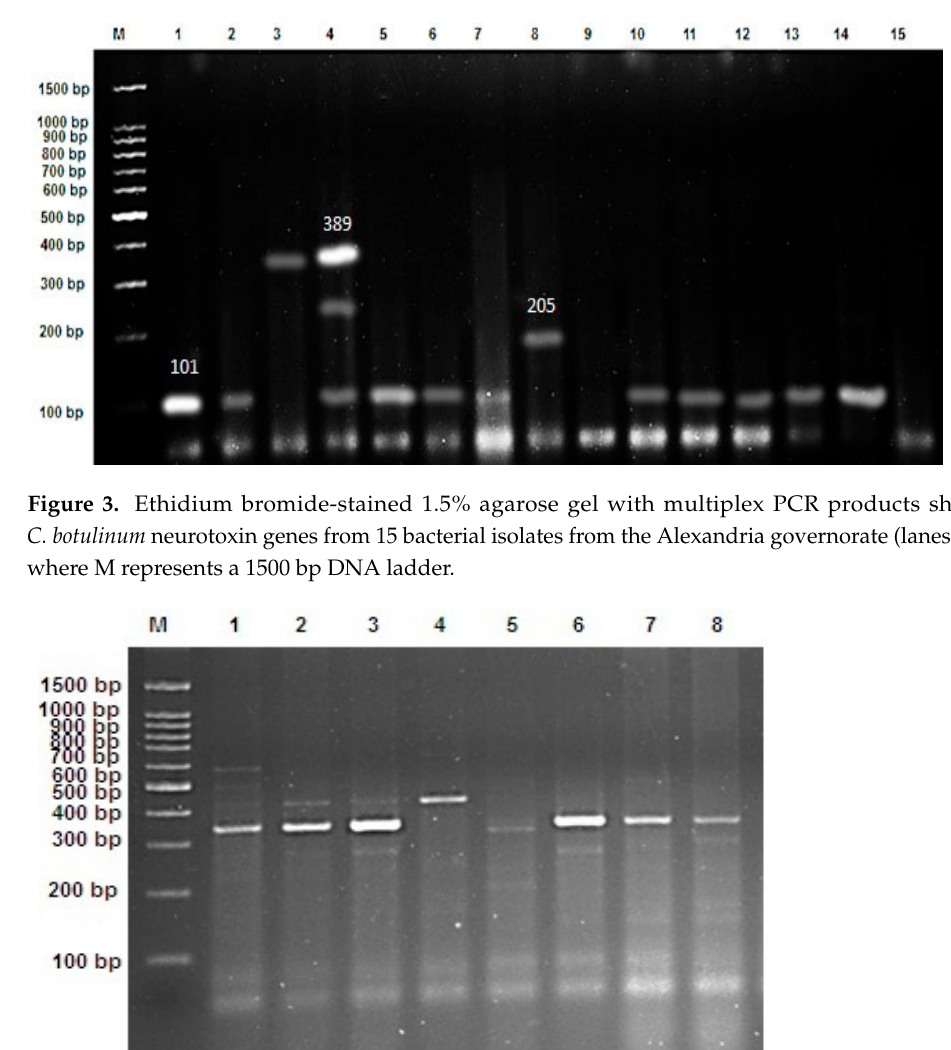
Figure 5. Ethidium bromide-stained 1.5% agarose gel with multiplex PCR products showed C. bot- ulinum neurotoxin genes from seven bacterial isolates from the Gharbia governorate (lanes 1–7), where M represents a 1500 bp DNA ladder. The data presented in Table 4 and Figure 3 regarding the Alexandria governorate postulates that clear bands were formed at 101, 205, and 389 bp for clostridial strain types A, B, and E, respectively. The bacterial isolates were divided into four main categories that differ in their profile pattern. The first comprises type A only, the second is characterized by type E, the third group contains type B, and the final group contains a mix of three toxin types, A, B, and E. Table 4. The banding pattern for the 15 studied bacterial isolates (isolated from the Alexandria gov- ernorate) using multiplex PCR. No. of Bacterial Isolates No. of Detected Bands Length of Bands (bp) Toxin Type 1